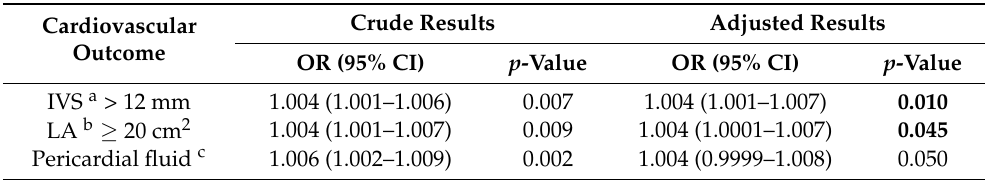
Table 4. The risk of selected cardiovascular outcomes depending on OPG concentrations—crude results and adjusted for prognostic